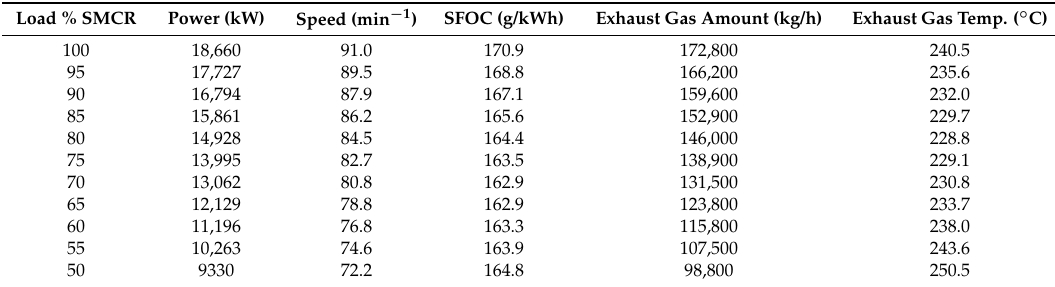
Table 1. SFOC and exhaust gases data, ISO conditions [27]. SFOC: specific fuel oil consumption; ISO: International Organization for Standardization; temp.: Temperature.